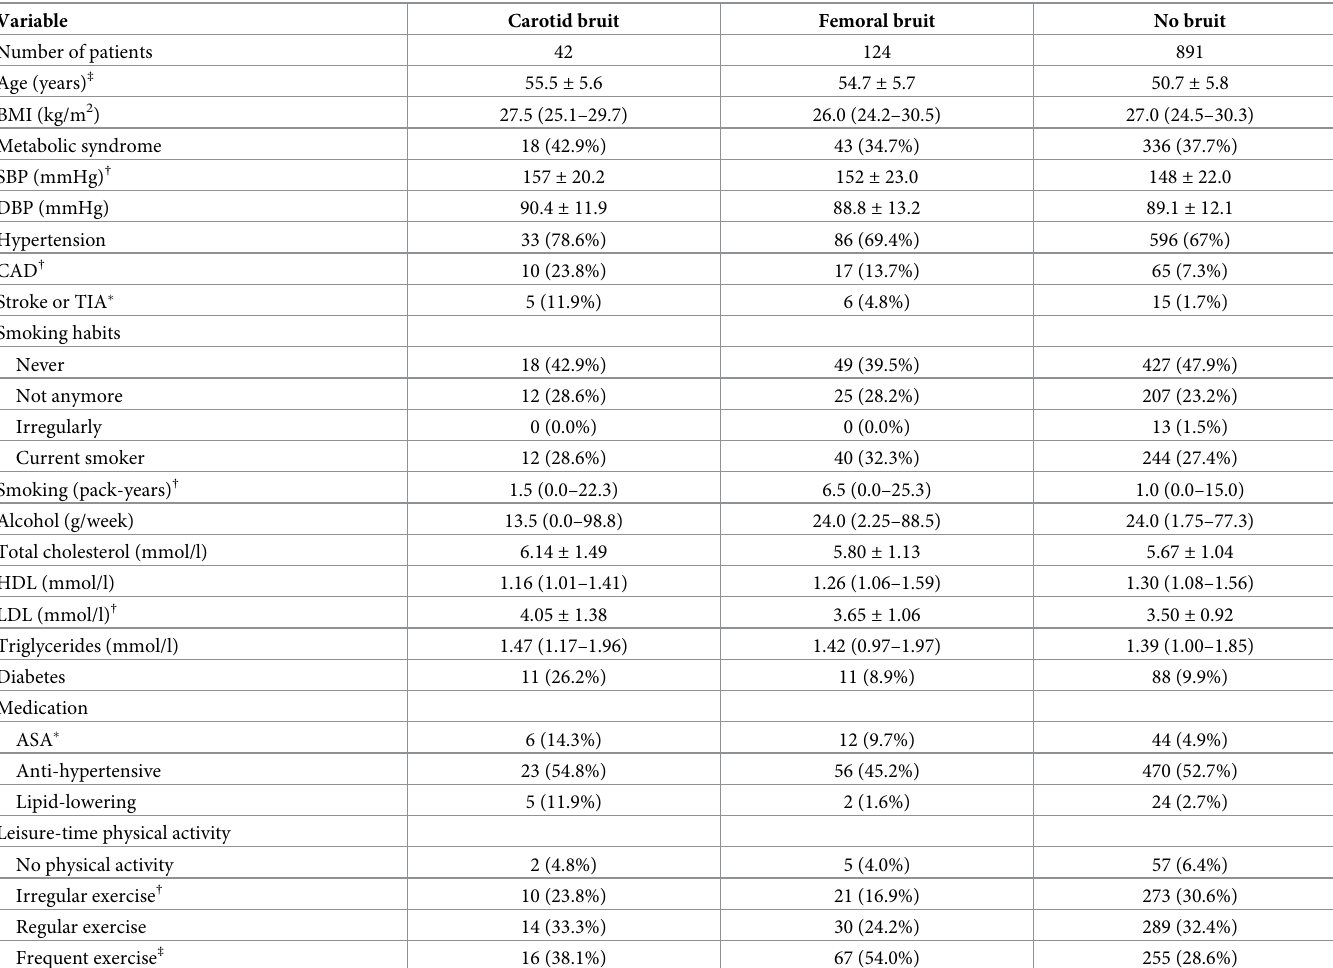
Table 1. Characteristics of the study